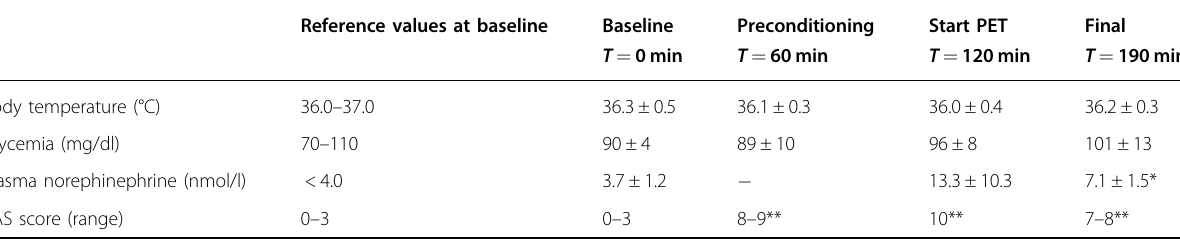
Table 2 Clinical parameters of FPLD2 patients subjected to cold exposure with reference values Reference values at